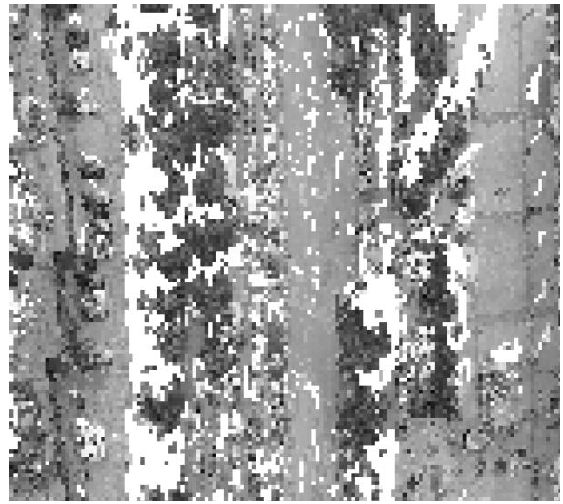
Figure 4 . DSM with the highlighting of the focusing box.